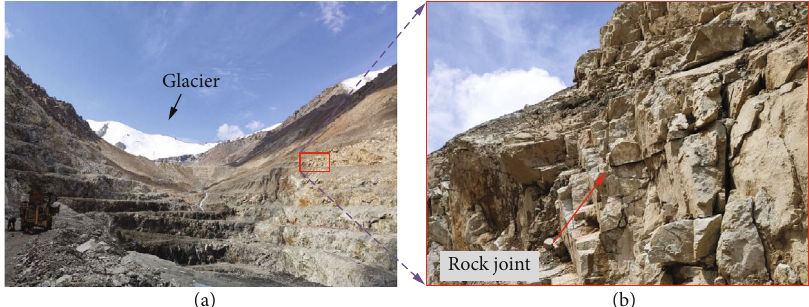
Figure 1: Rock joint sample collection: (a) high elevation slope and (b) massive block structure with rich joints of the natural slope.